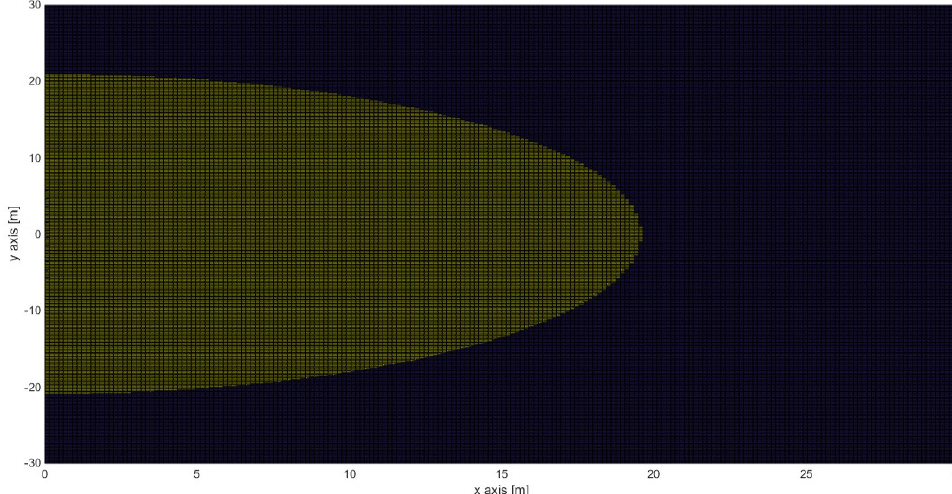
Figure 21. Area of electric field strength with values higher (yellow) and lower (blue) than the limit of 1.25 V/m for method “C” of linear current source for a linear frame of 13 electrodes with D el = 1.0 m for the area of Korakia ( ρ S = ∞ , without dam, L = 1.1815 m, ρ w = 0.25 Ω · m, θ = 248 ◦ , J maintenance_steady = 22 A/m 2